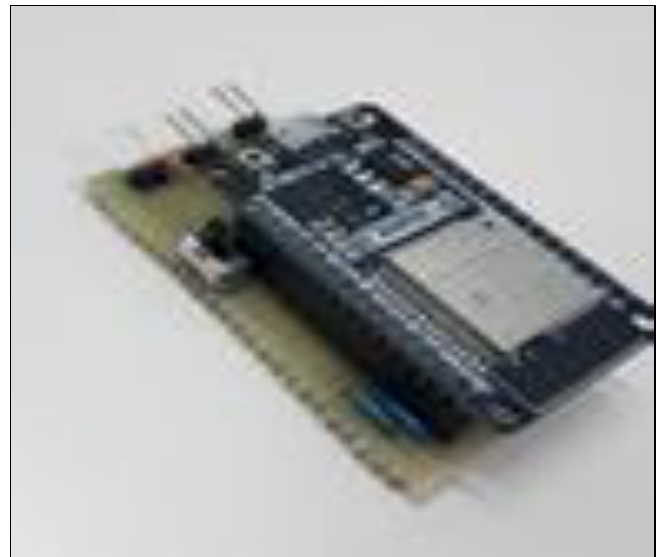
Figure 5: Circuit board developed to connect ESP32 microcontroller and vibrating motors via wired